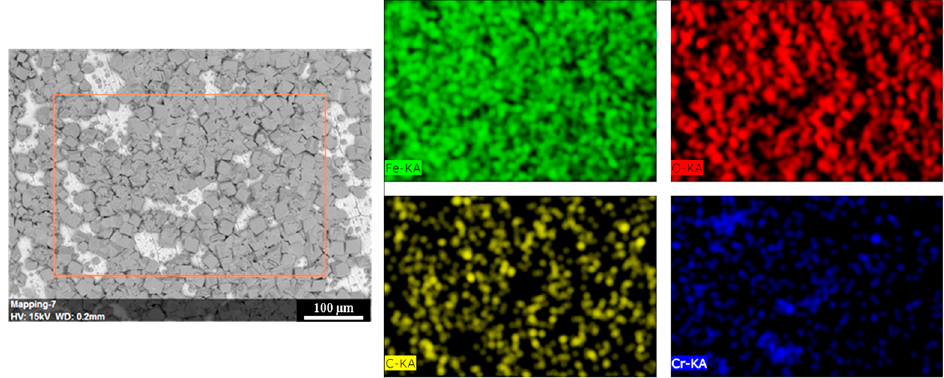
Figure 5. Product film morphology and energy spectrum element analysis of 1Cr steel in high temperature and high pressure (114 ◦ C-CO 2 : 0.73 MPa) corrosion environment.